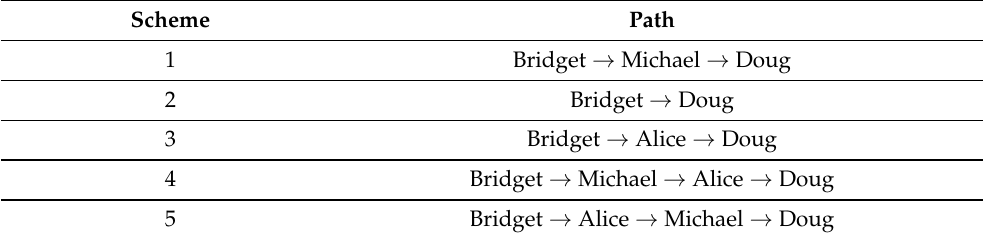
Table 4. Different schemes from start node to destination node. Scheme